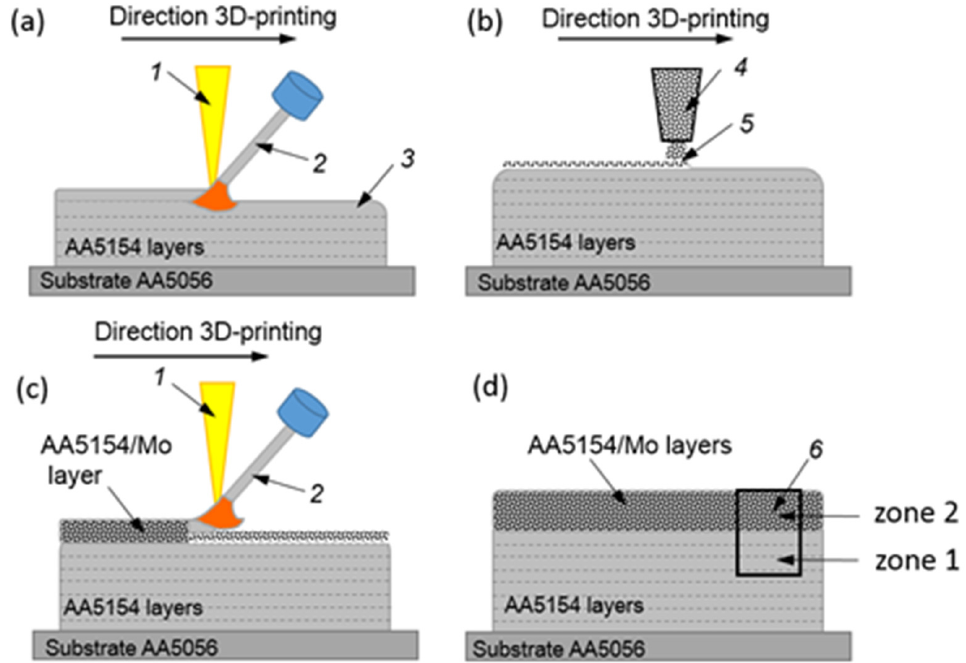
Figure 1. EBAM process stages such as electron beam deposition of AA5154 layers ( a ) spreading a Mo powder-bed ( b ) remelting the Mo powder-bed with deposition of AA5154 ( c ) as-built